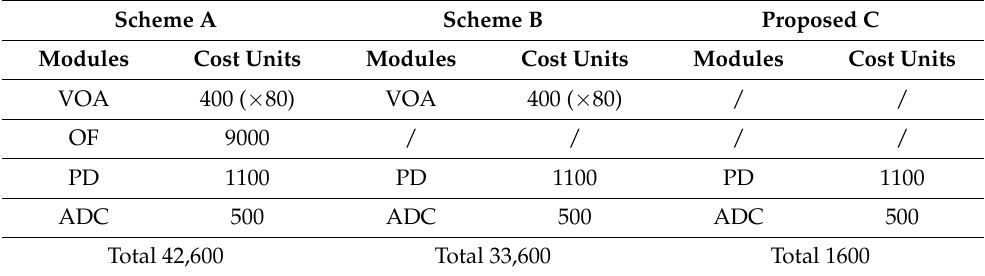
Table 1. The cost of different modules used in the three OPM schemes.